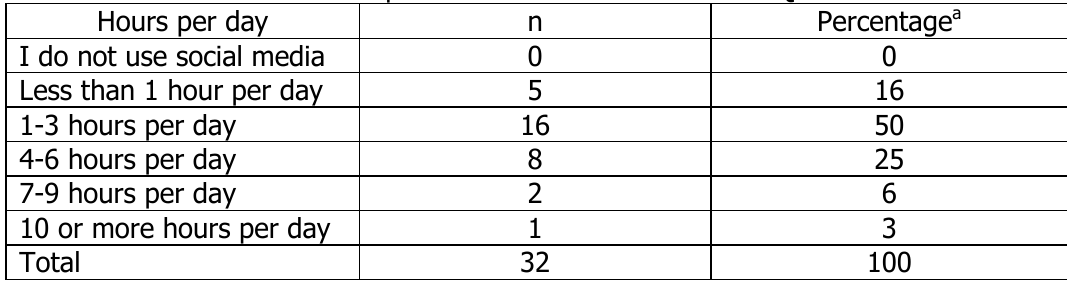
Number of Hours per day spent using Social Media Reported by Louisiana 4-H Alumni that Completed the Zammit Social Media Questionnaire